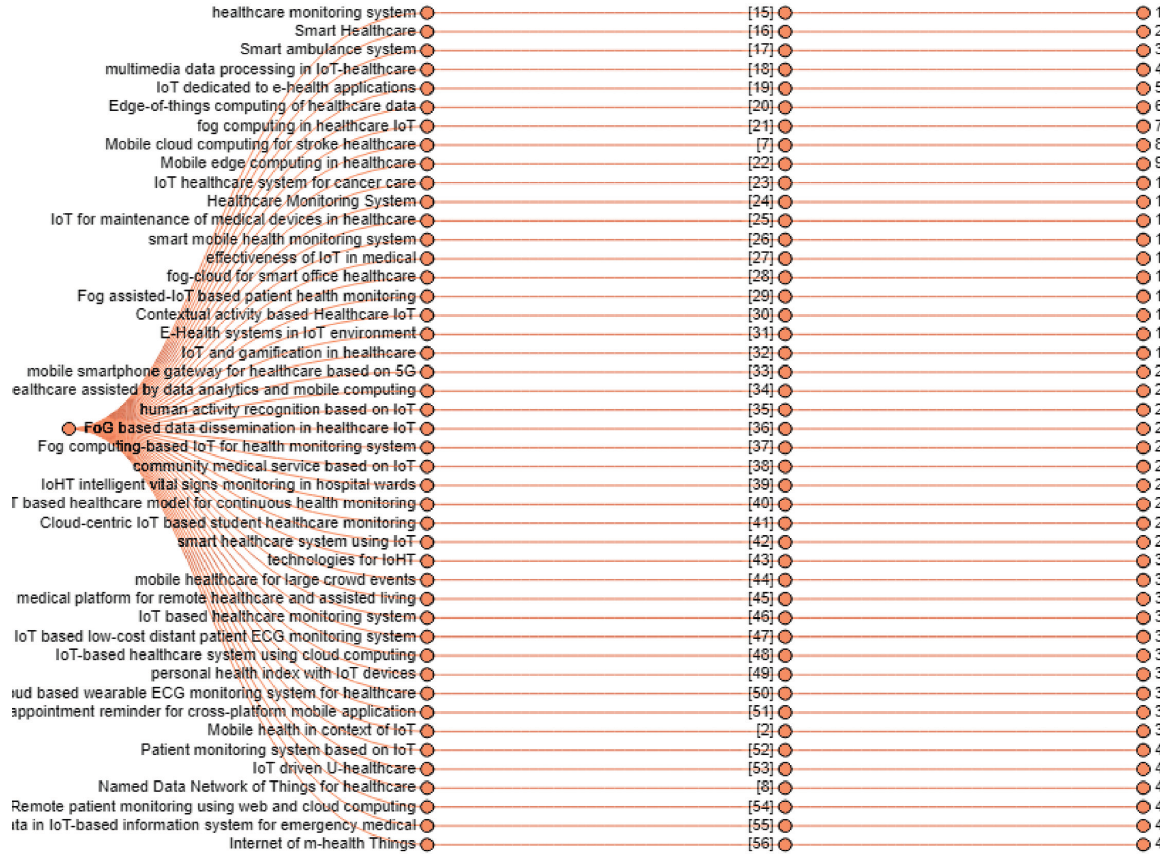
Figure 2: Approaches for facilitating IIoHT [2, 7, 8, 15–56].